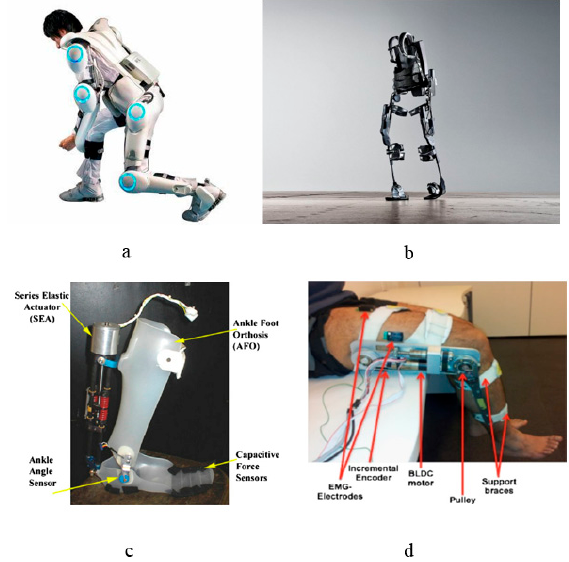
Figure 1. Exoskeleton Types ( a ) HAL 5 exoskeleton [17] ( b ) Ekso exoskeleton [17] ( c ) MIT AAFO [18] ( d ) Knee joint exoskeleton [19].